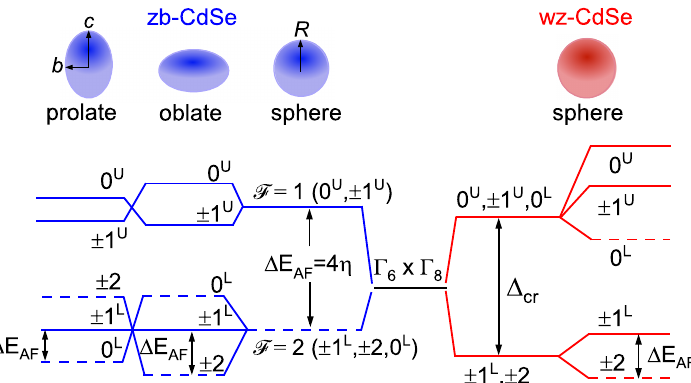
Figure 1. Schematic of the fine structure of the band-edge exciton formed by an electron from the Γ Γ 6 conduction band and a hole from the 8 valence band in spheroidal zb-CdSe NCs with different semiaxes aspect ratio c / b , including the spherical with NC radius R = c = b , and spherical wz-CdSe NCs. Solid and dashed lines correspond to bright and dark exciton states, respectively. wz-CdSe NCs are considered within the quasi-cubic approximation, i.e., as zb-CdSe NCs with split valence sub-bands of heavy and light